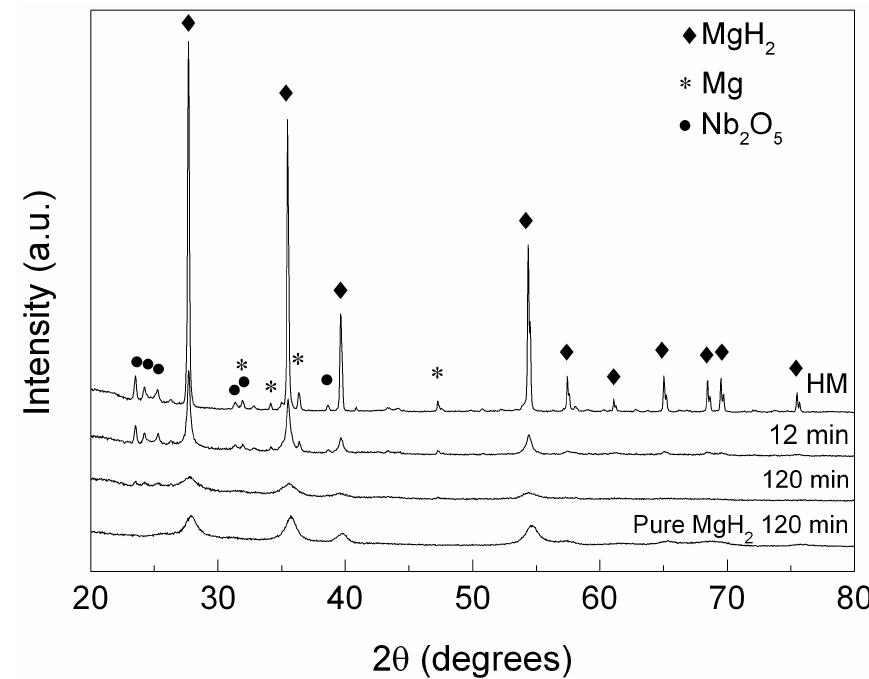
Figure 2. X-ray diffraction profiles of the hand mixed and ball-milled samples.